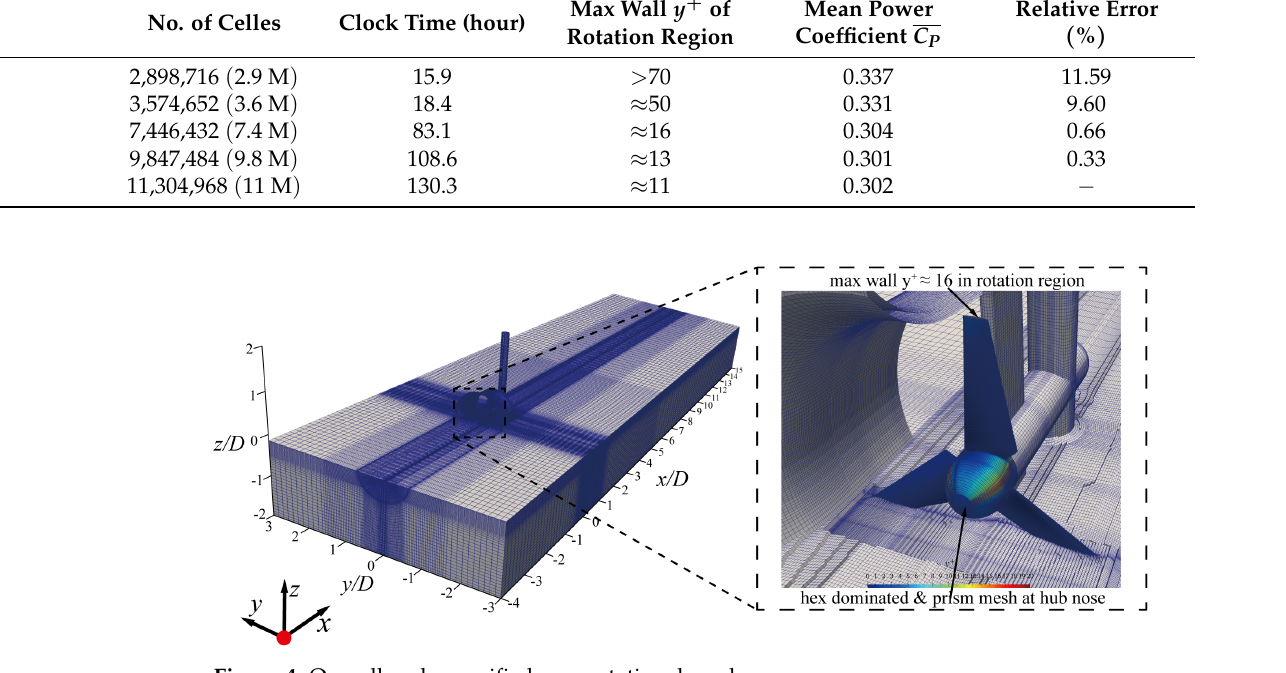
Figure 4. Overall and magnified computational